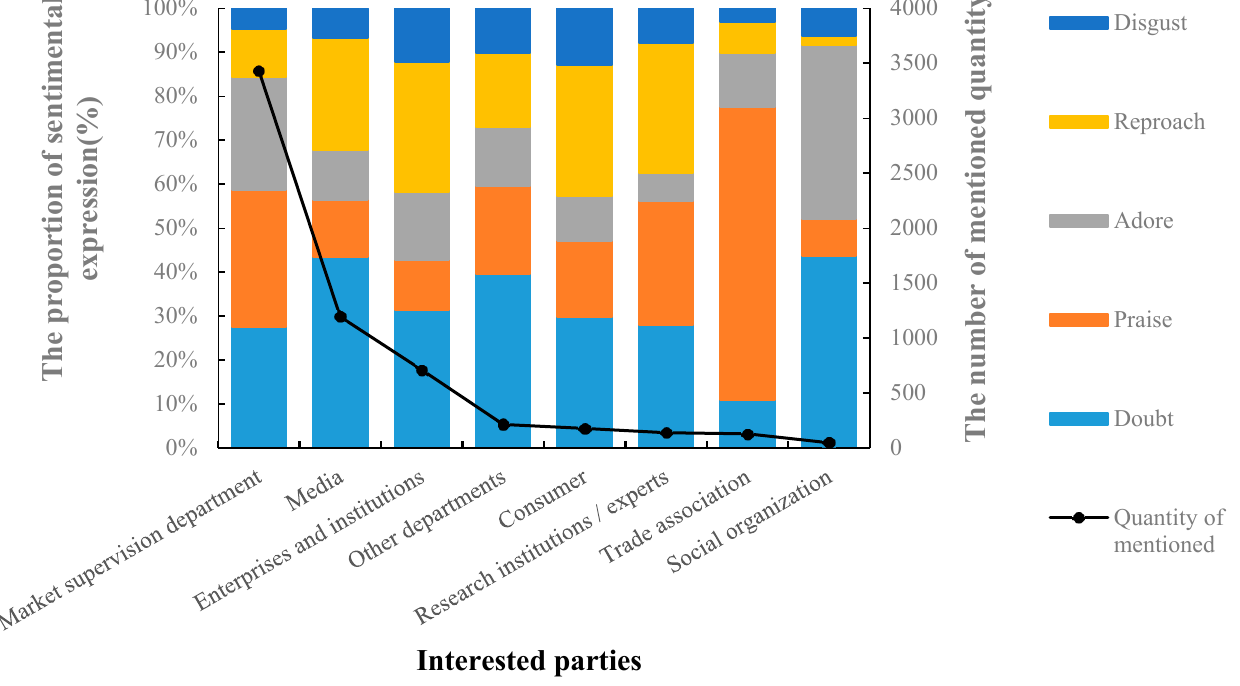
Figure 2. Main emotion of consumers toward the interested parties.